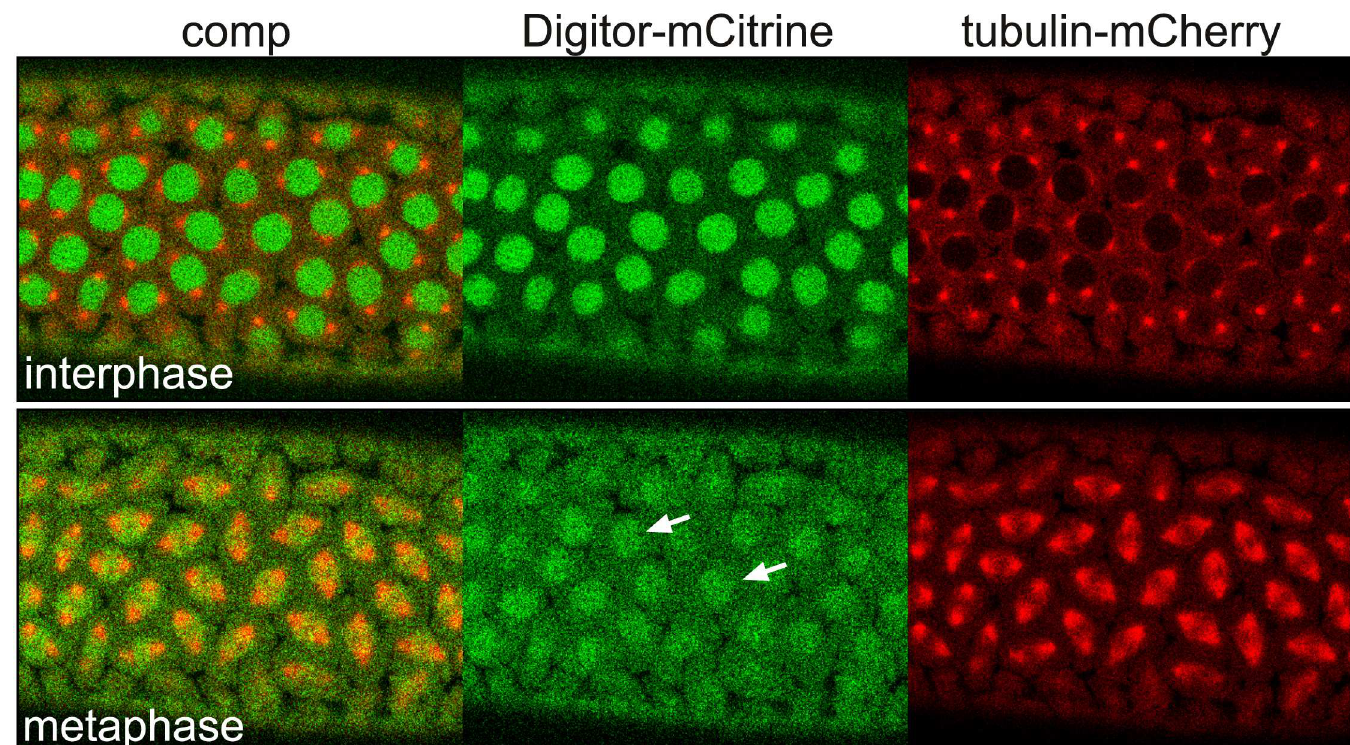
Fig 6. Confocal time-lapse analysis of 3xHA-Digitor-mCitrine during mitosis in a syncytial Drosophila embryo. The figure shows the relative dynamicsof the 3xHA-Digitor-mCitrineconstruct (in green) and tubulin-mCherry (in red) at interphaseand metaphase, respectively.Arrows indicate the localization of the 3xHA-Digitor-mCitrineconstruct in the spindleregionafter NEB and microtubule spindleformation at metaphase.